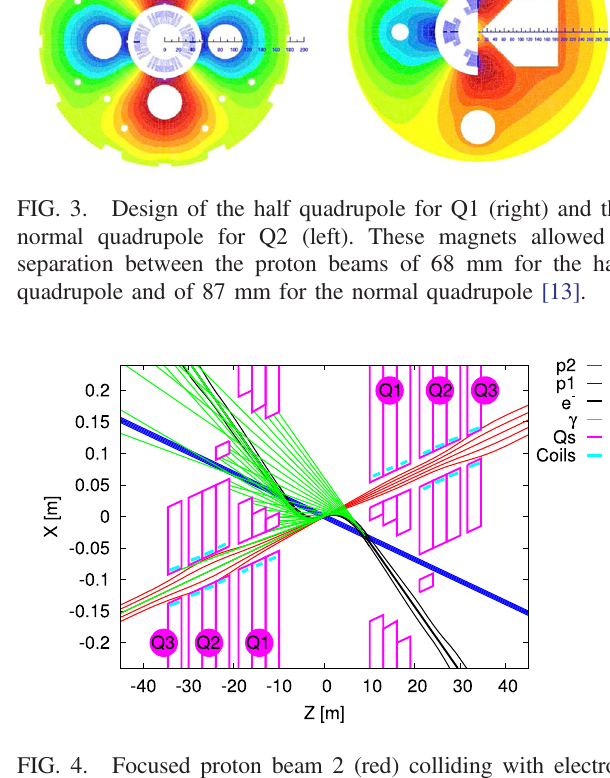
FIG. 4. Focused proton beam 2 (red) colliding with electron beam (black) while unfocused proton beam 1 bypasses the interaction. Each proton and electron beam passes through its corresponding aperture in the inner triplet [15].